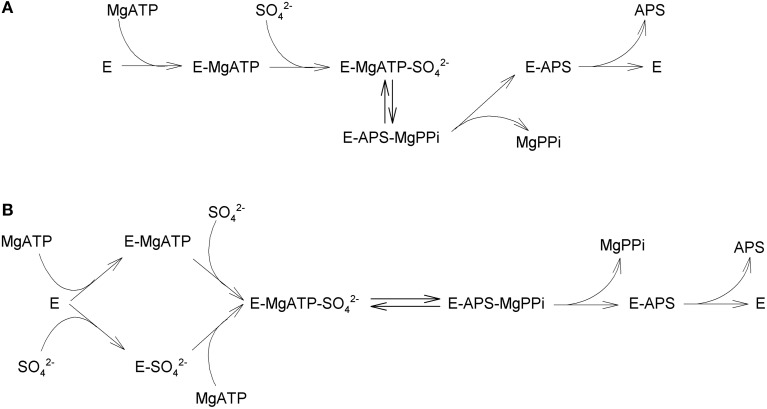
ATP sulfurylase reaction mechanism. Panel (A) depicts the ordered reaction mechanism described by Farley et al. (1976) and Ravilious et al. (2013); panel (B) depicts the random reaction sequence as described by Seubert et al. (1983, 1985).